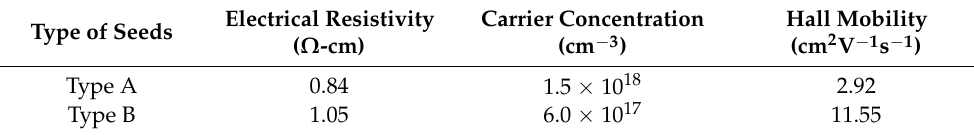
Table 1. Electrical properties of ZnO films hydrothermally grown on Type A and Type B